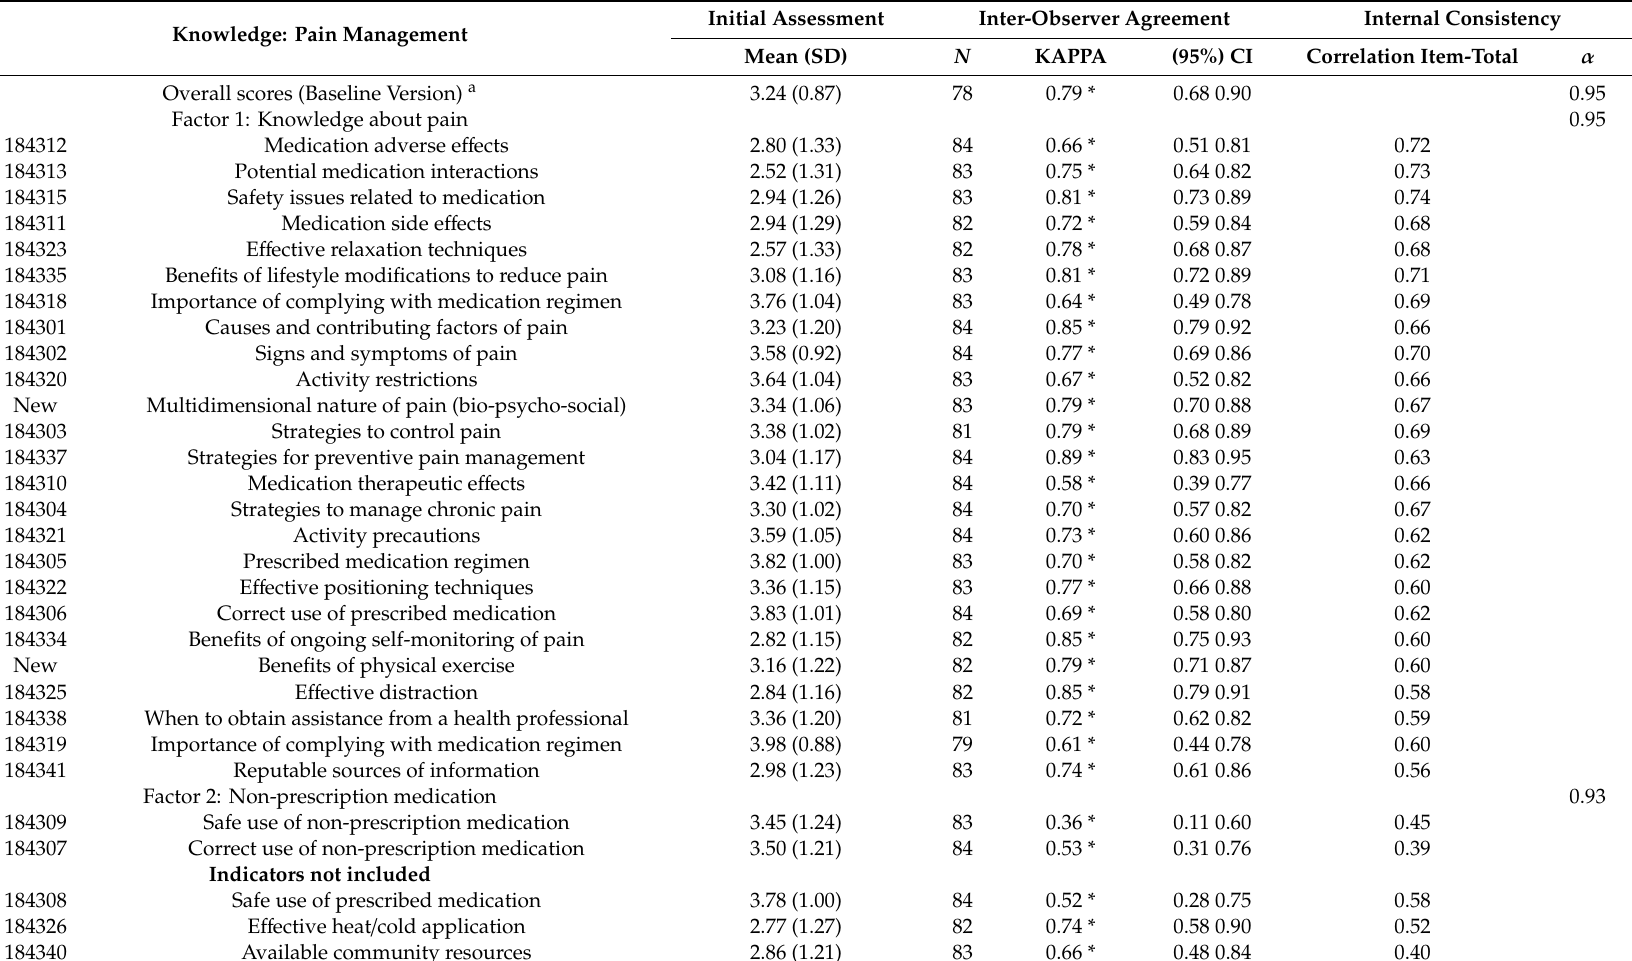
Table 7. Reliability of the outcome Knowledge: Pain management . Inter-observer agreement and internal